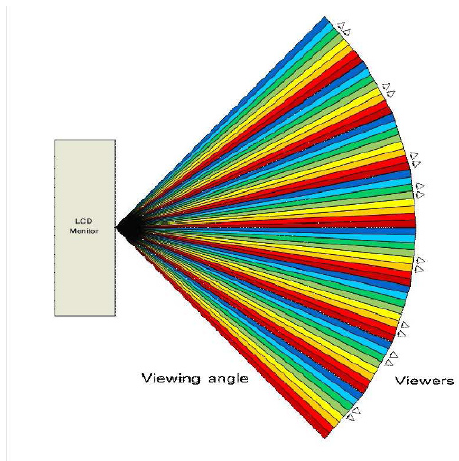
Figure 23. Alioscopytechnologyisbasedon8distinctpointsofview (POV) each of which is aligned to the LCD’s sub-pixel. 2 of the 8 points of view can be seen by the user in a sweet spot. Each viewing angle is 8 degrees from sweet spot to sweet spot. Illustration: Alioscopy USA,